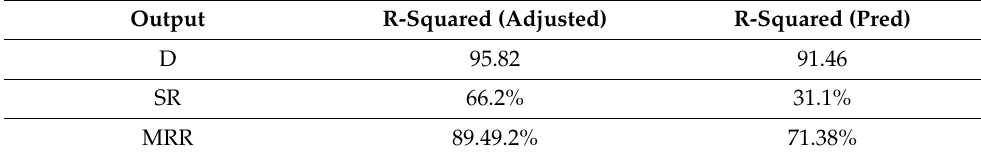
Table 6. Model accuracy parameters for output